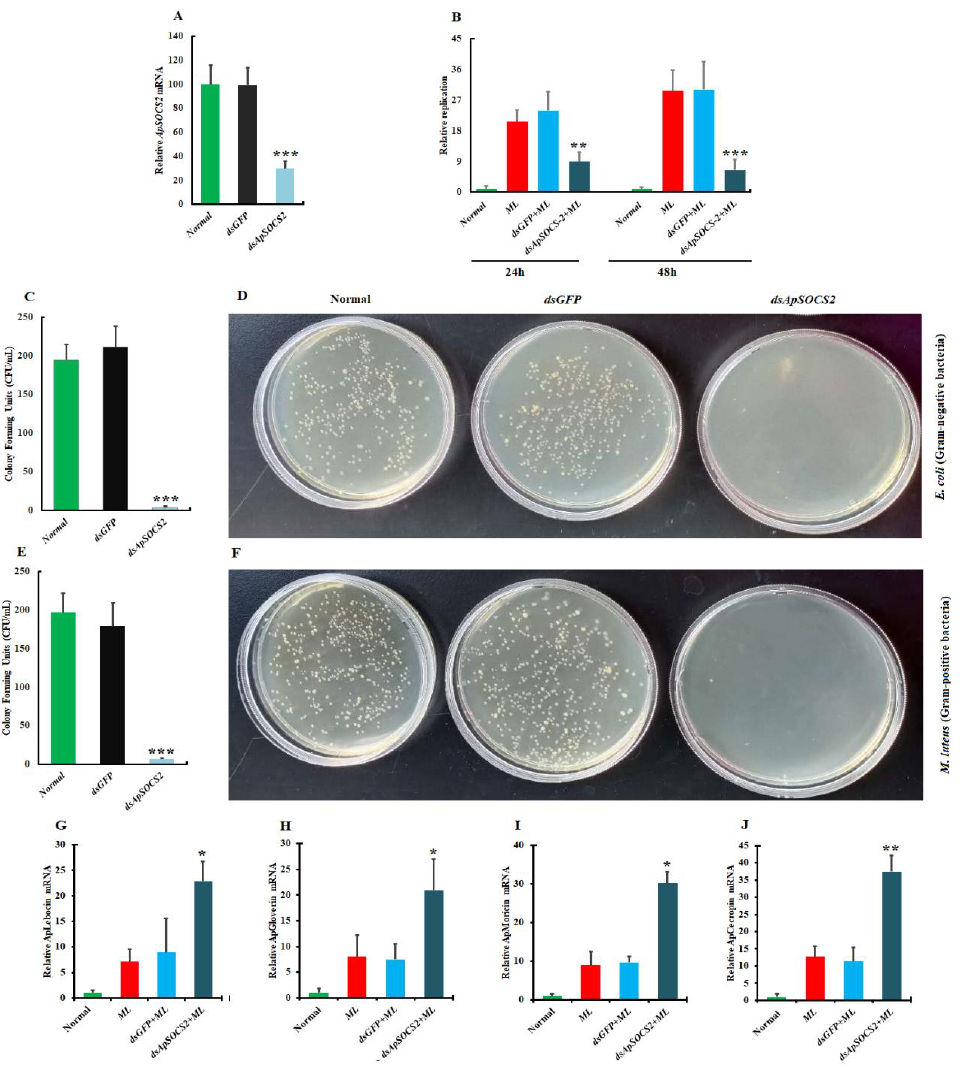
Figure 7. Loss-of-function analysis of ApSOCS-2 on bacterial survival and antimicrobial peptides production normalized to 18 S and actin-1 (Actin-1 normalized: Figure S5). ( A ): dsApSOCS-2 injection strongly reduced the production of ApSOCS-2 in hemocytes; ( B ): qPCR replication rate analysis exhibited that treatment of A. pernyi larvae with dsApSOCS-2 decreased the replication rate of M. luteus . The plasma antibacterial activity was increased in the ApSOCS-2 depletion ( C – F ). Plasma was sampled from A. pernyi treated with ApSOCS-2 dsRNA or GFP dsRNA. Equal volumes (10 μL) of plasma and bacterial suspension were incubated at 25 °C for 1 h. The bacteria ( M. luteus ) was in- jected into dsApSOCS-2 treated A. pernyi larvae, and mRNA expression levels of ( G ) lebocin, ( H ) gloverin, ( I ) moricin, and ( J ) cecropin were measured by qRT-PCR. Normal: untreated sample; ML: M. luteus -treated; dsGFP + ML: treated with both dsGFP and M. luteus ; and dsApSOCS-2 + ML: treated with both dsApSOCS-2 and M. luteus . Asterisks indicate significant differences (* p < 0.05, ** p < 0.01, *** p < 0.001).